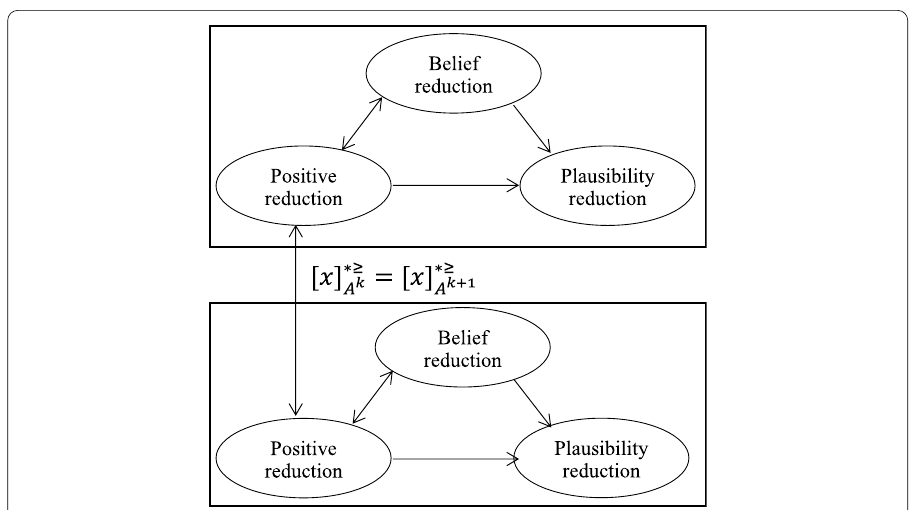
Fig. 3 The transitivity of several reductions between k and k